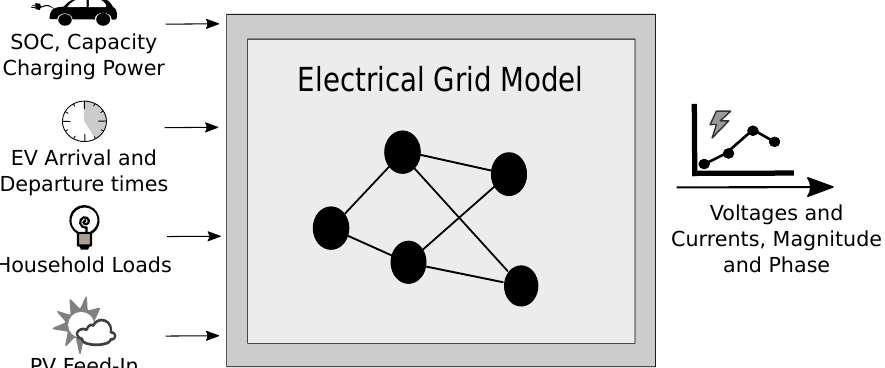
Figure 2. Conceptual approach, with input and output data and models employed. SOC = state of charge; EV = electric vehicles; PV =